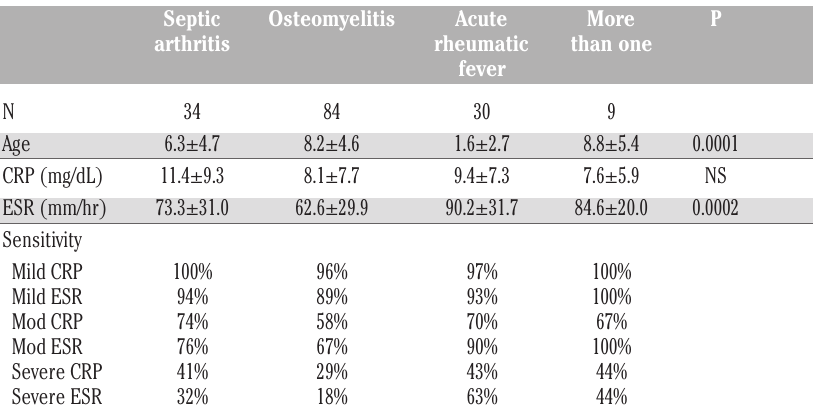
Table 1. Mean age, C-reactive protein, and erythrocyte sedimentation rate values (± stan- dard deviation) among the different disease groups.